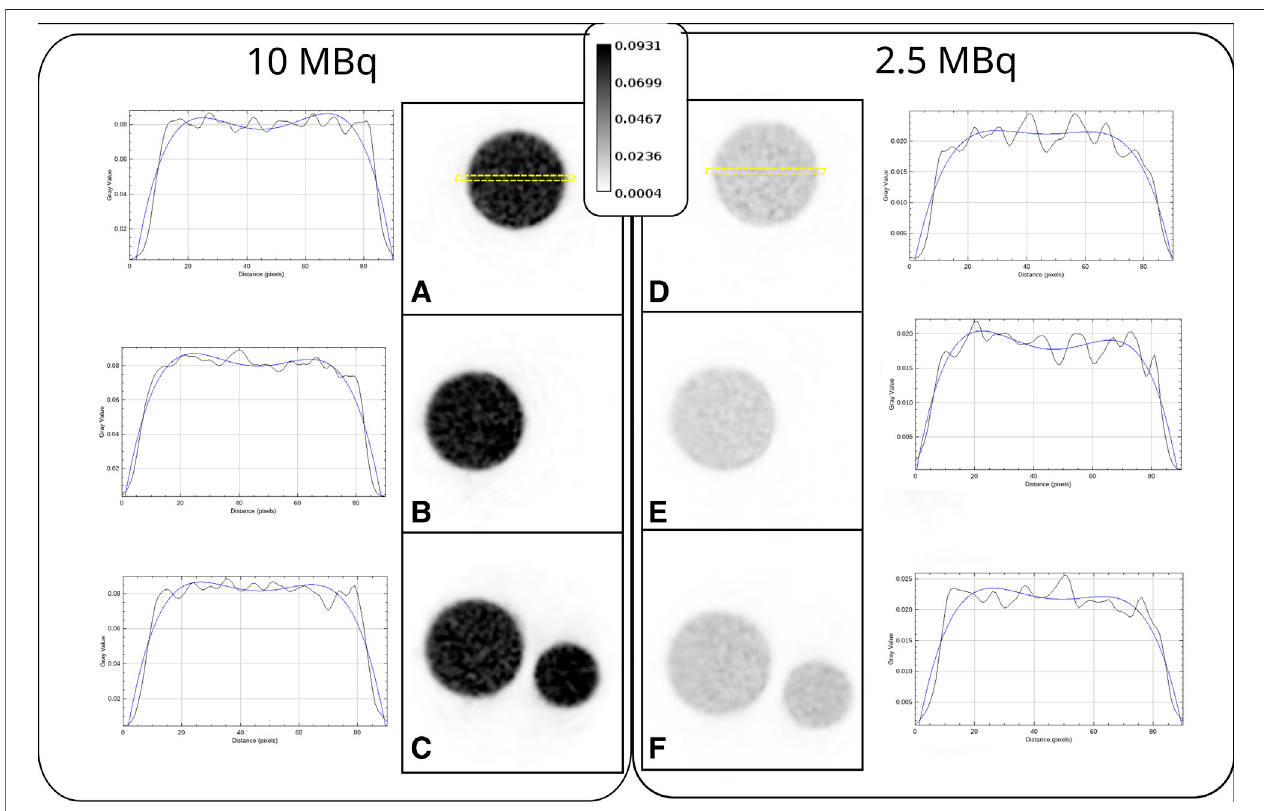
FIGURE 4 | Assessment of uniform region asymmetry for the NEMA IQ phantom in the single centered (A, D) , offset (B, E) and dual (C, E) cases. Yellow lines indicate selected region. Adjacent graphs indicate line pro fi les fi tted with a polynomial function.